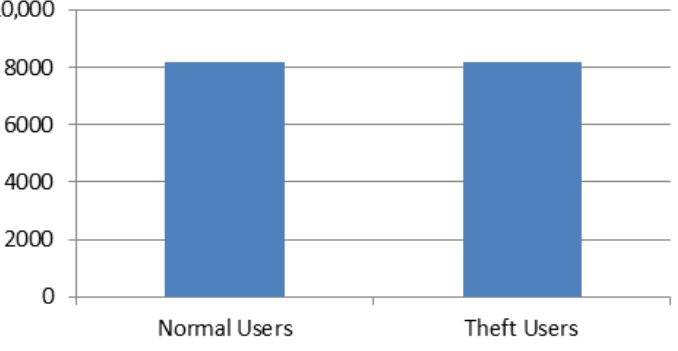
Figure 4. Normal and theft users’ distribution after SMOTE